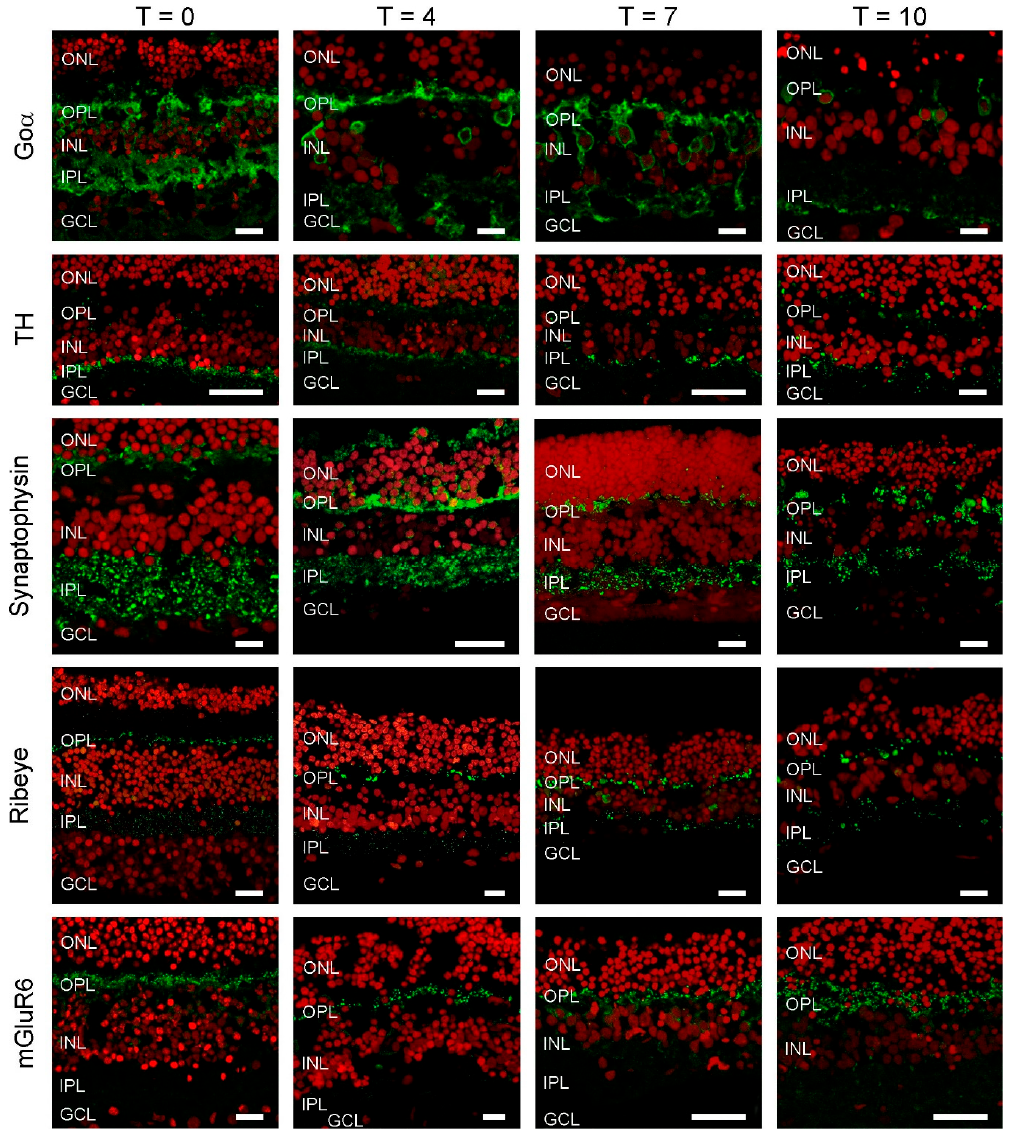
Figure 2. Cellular markers indicate that retinal morphology is relatively undisturbed. Go α (green), a marker for ON-bipolar cells, labels cells in the INL with dendritic processes extending into the OPL and big axon terminals in the IPL. At T10, labelling seems less apparent. Tyrosine hydroxylase (TH) (green), a marker of dopaminergic amacrine cells shows an intense band of labelling at the border of the INL and IPL with some puncta in the OPL. This labelling pattern does not change dramatically during culturing. Synaptophysin (green), a synaptic vesicle marker shows strong labelling in both plexiform layers. The labelling pattern remains relatively stable during the 10 days of culturing. Ribeye (green), a marker for ribbon synapses is present in both plexiform layers. Note the horseshoe shaped structures in the OPL, which are indicative of cone synaptic terminals. The labelling pattern remains relatively stable during the 10 days of culturing. mGluR6 is a marker for the photoreceptor to ON-bipolar cell synapse. Strong labelling in the OPL remains throughout the whole culturing period. Red: Nuclear stain ethidium bromide. Scale bar represents 10 µM. We also investigated if the synaptic structures between cells were still intact. At all time-points, synaptophysin labelling indicated that synaptic vesicles were present in both the IPL and OPL.